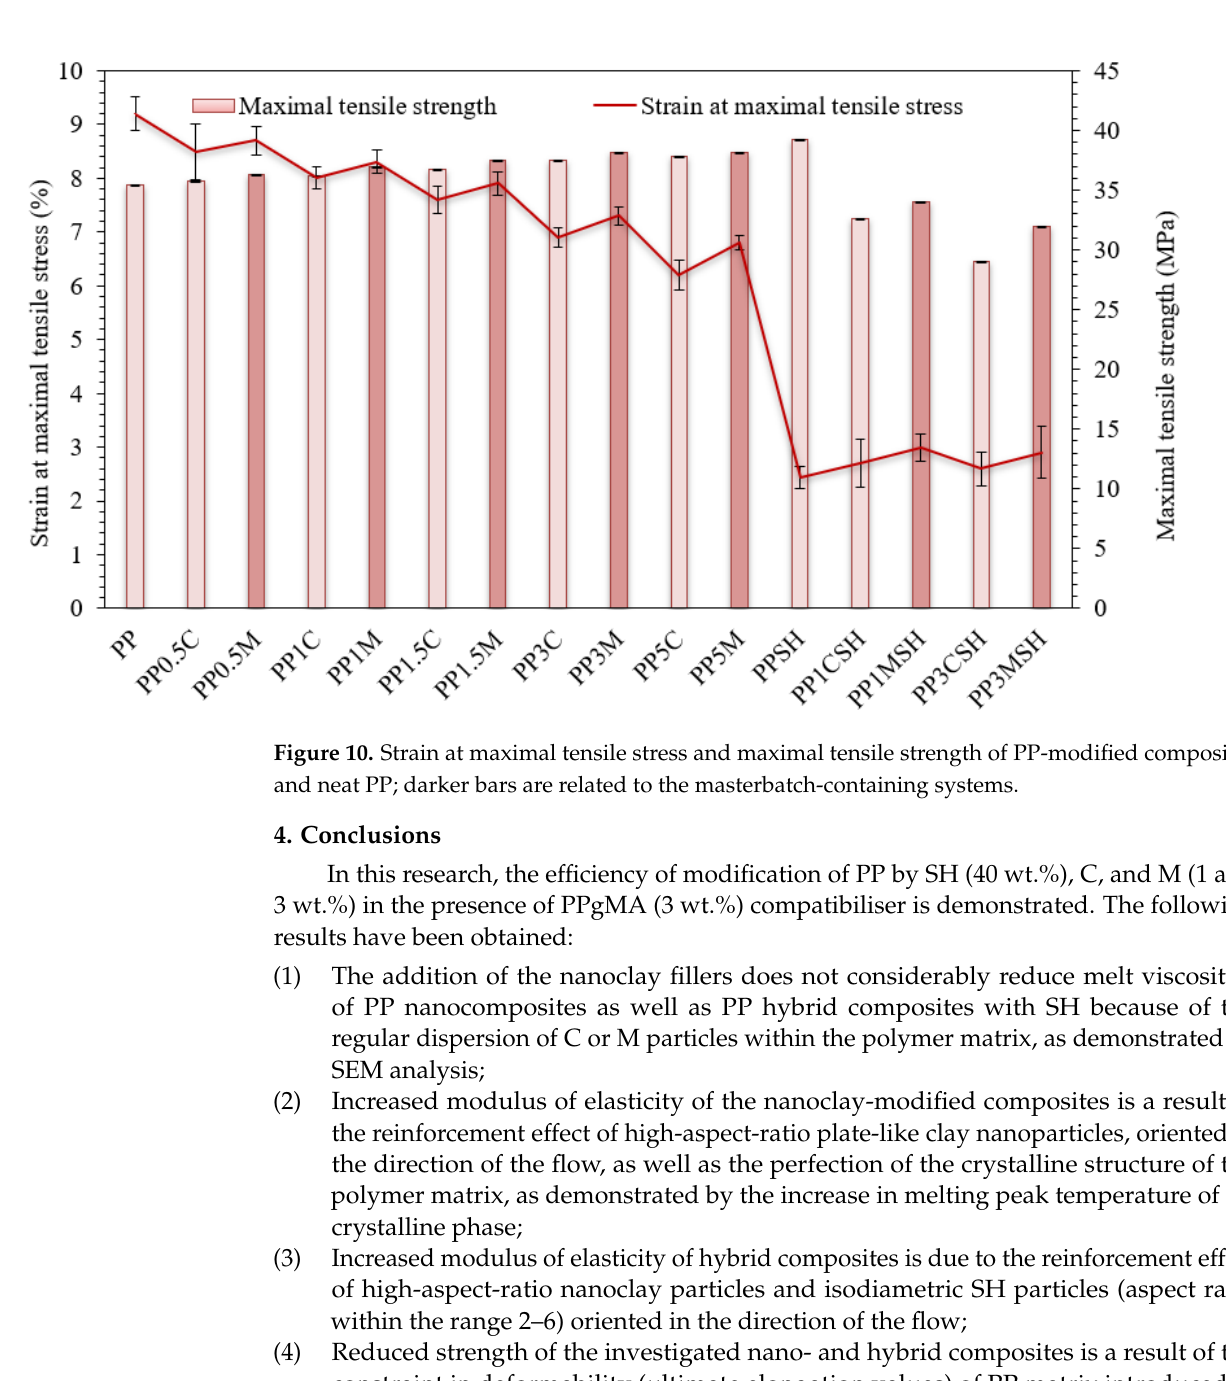
Figure 9. Tensile modulus of PP composites compared to neat PP; darker bars are related to the masterbatch-containing systems.